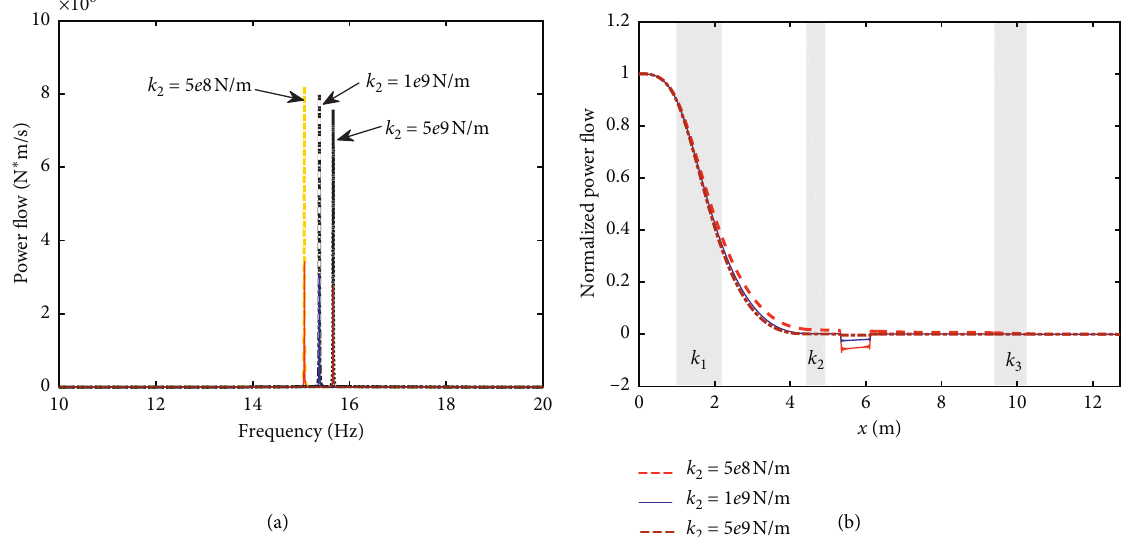
Figure 9: Power flow analysis of the propulsion system with different stiffnesses of stern front bearing. (a) Power flow through bearing; (b) power flow distribution across the whole structure.